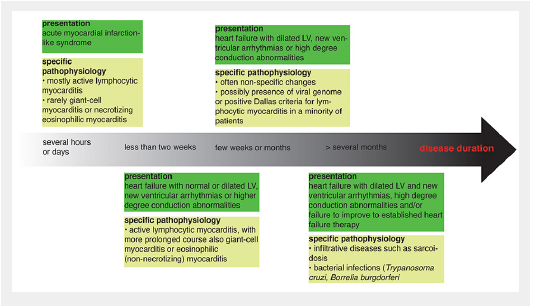
The common clinical presentations of myocarditis and possible specific pathologies. The scheme is adapted from [64]. LV = left